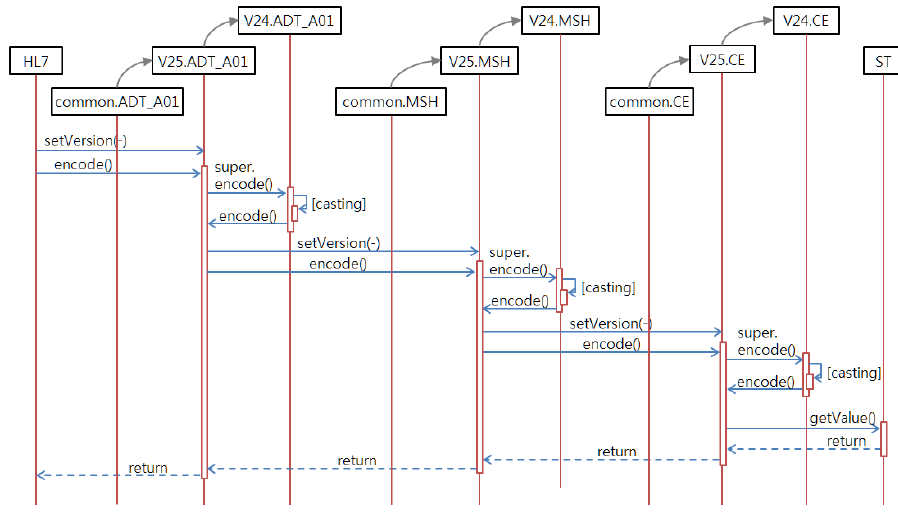
Fig. 10. Method diagram for encoding of an HL7 message for forward